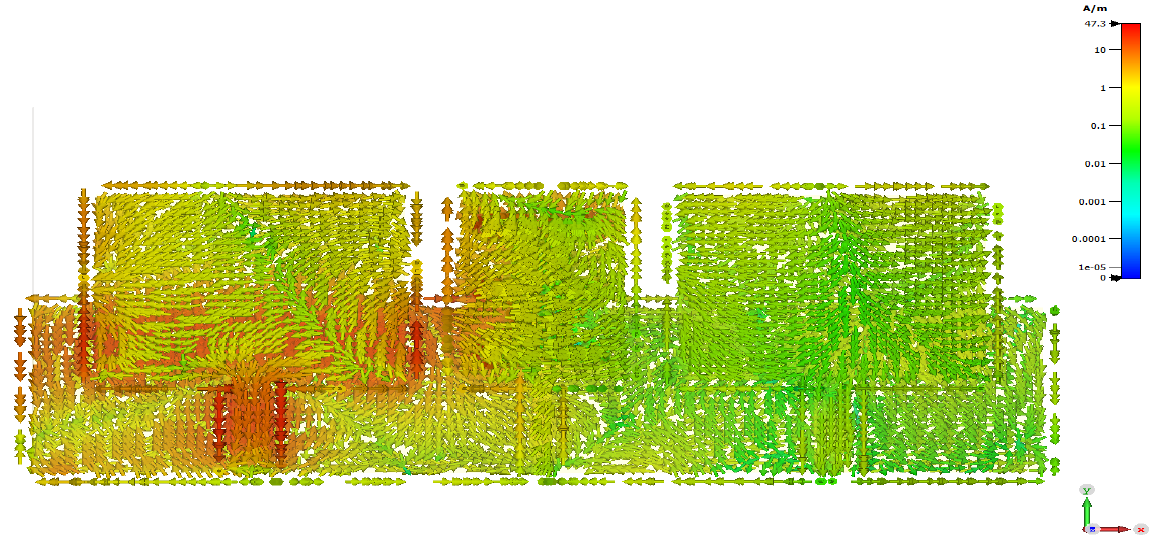
Figure 9. Current density of 2 × 1 microstrip patch antenna array with slotted MTM-DS.